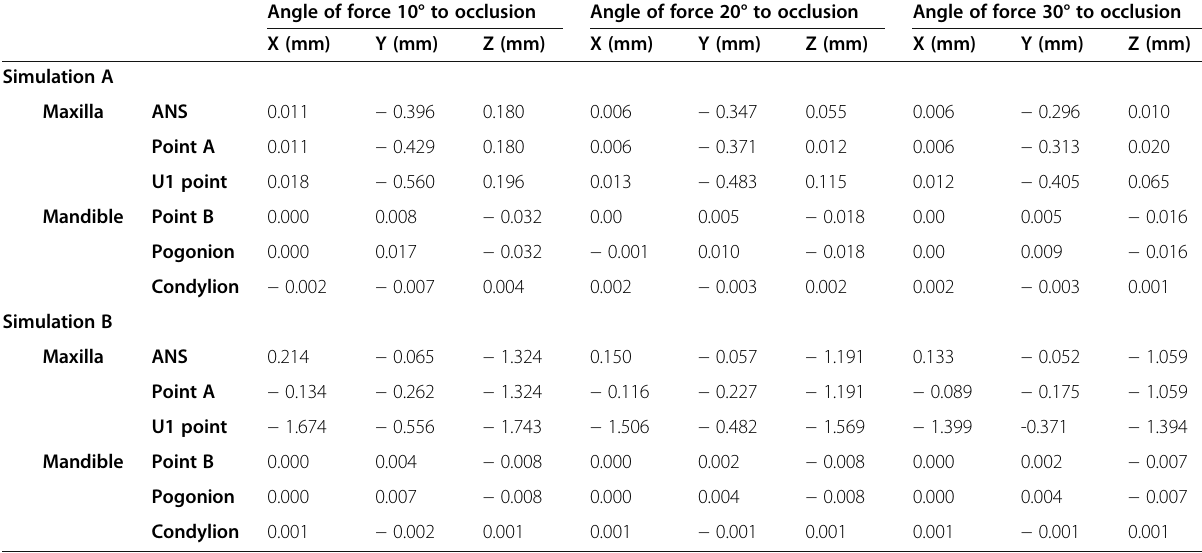
Table 3 Comparison of displacement of the surface landmarks in the maxillofacial structures with maxillary protraction without maxillary expansion (Simulation A) when 250-g force was